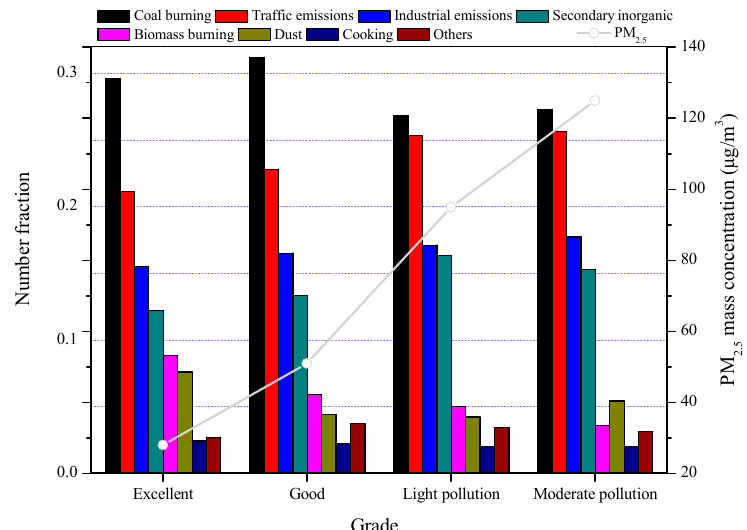
Figure 5. Number fraction of eight particle types in various pollution cases.